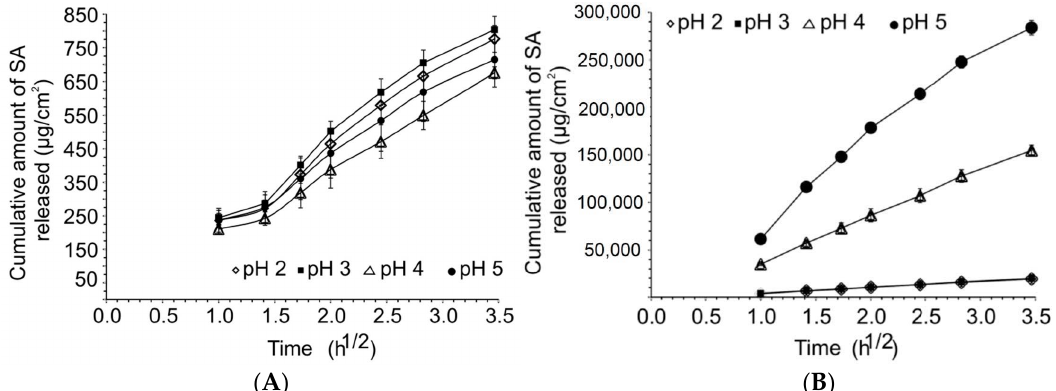
Figure 1. ( A ) Cumulative release of salicylic acid from unsaturated solutions at various pH levels. ( B ) Cumulative release of salicylic acid from saturated solutions at various pH levels. (The graph of pH 3 overlays the graph of pH 2).